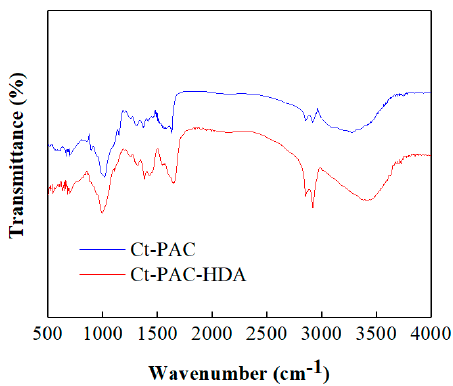
Figure 2. Fourier-transform infrared spectroscopy (FTIR) spectra of Ct-PAC and Ct-PAC-HDA beads.